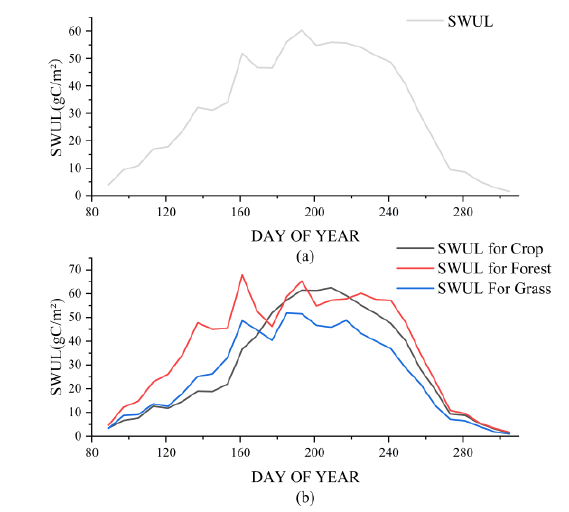
Figure 4. The trend of average SWUL in NEC(a) and the trend of SWUL (b) based on biome in the growing